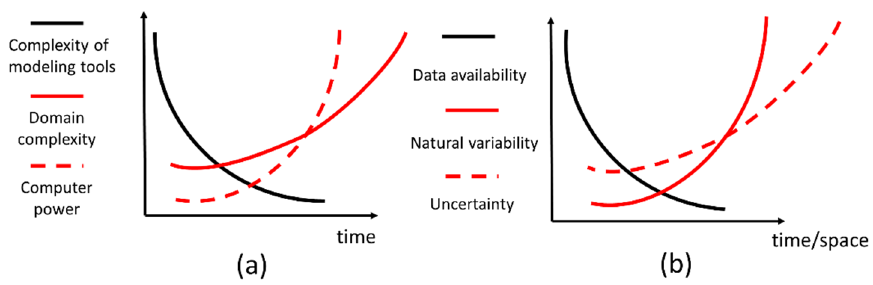
Figure 1. Illustration of the ( a ) complexity and ( b ) uncertainty paradigms (after [1]).